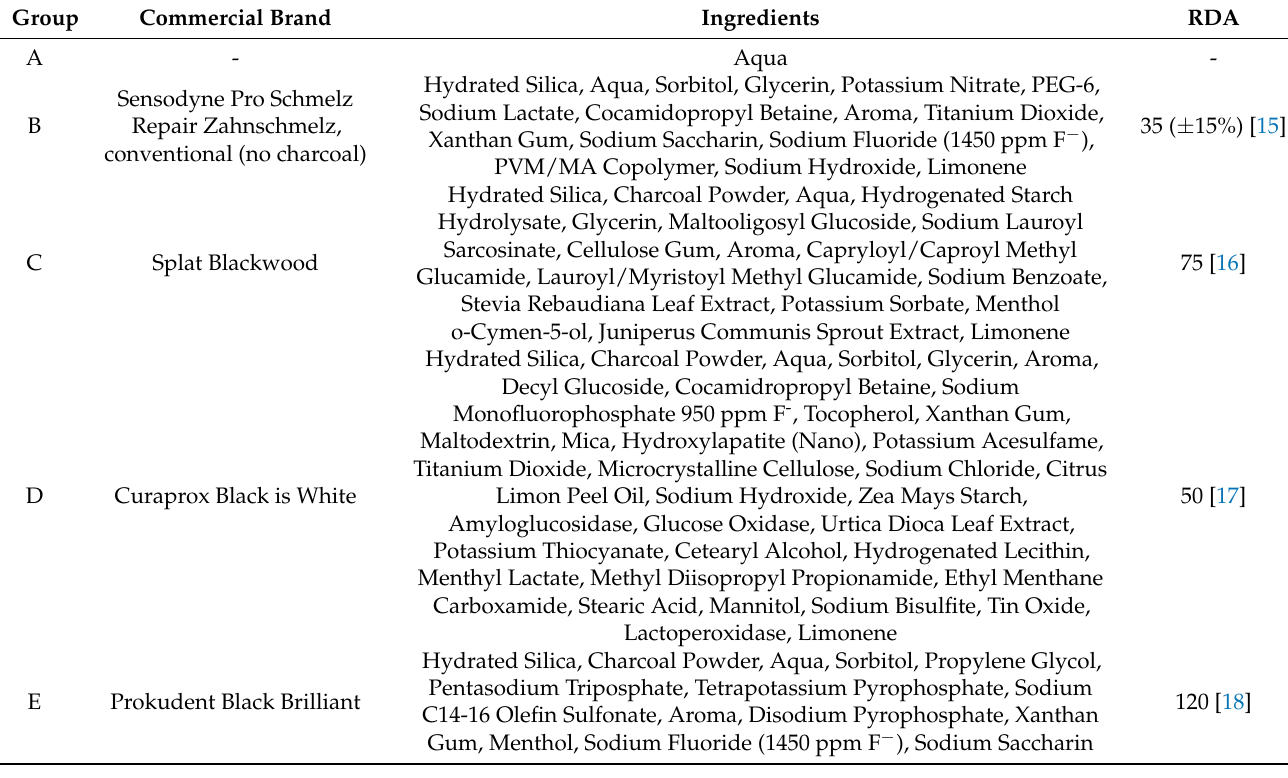
Table 1. Information about the ingredients and relative dentin abrasion (RDA) value of the used toothpastes.